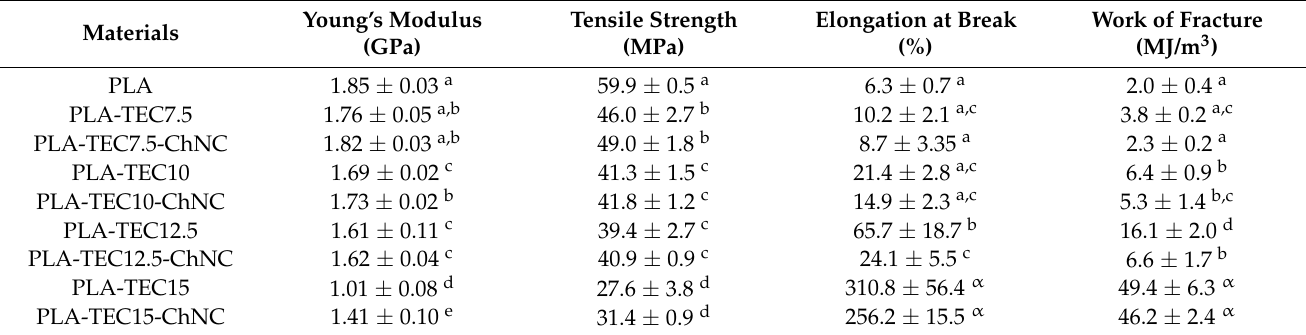
Table 3. Mechanical properties of PLA, PLA with TEC and the corresponding